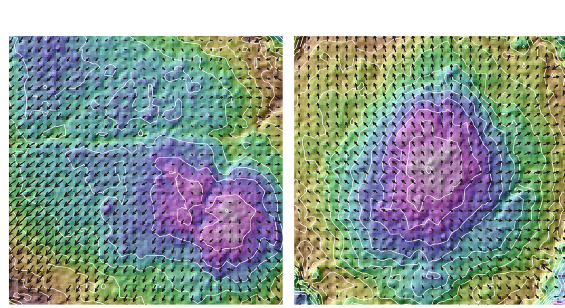
Figure A1. Details of displacement field and topography of north- ern (left panel) and middle (right panel) fine-domain centres. Fine– coarse boundaries appear only in corners of the sections shown. El- evations are colour-coded (2007 elevations; 2010 elevations give a similar picture) and in addition indicated by 1cm contours (white lines). Elevation range in both sections ∼ 10cm. Displacement vec- tors have 5cm spacing and magnitudes of up to 2cmyr − 1 . Back- ground: hillshade of 2007 DEM. Displacement vectors point ups- lope in some areas, and they cross some of the cracks, indicating partial advection of cracks.